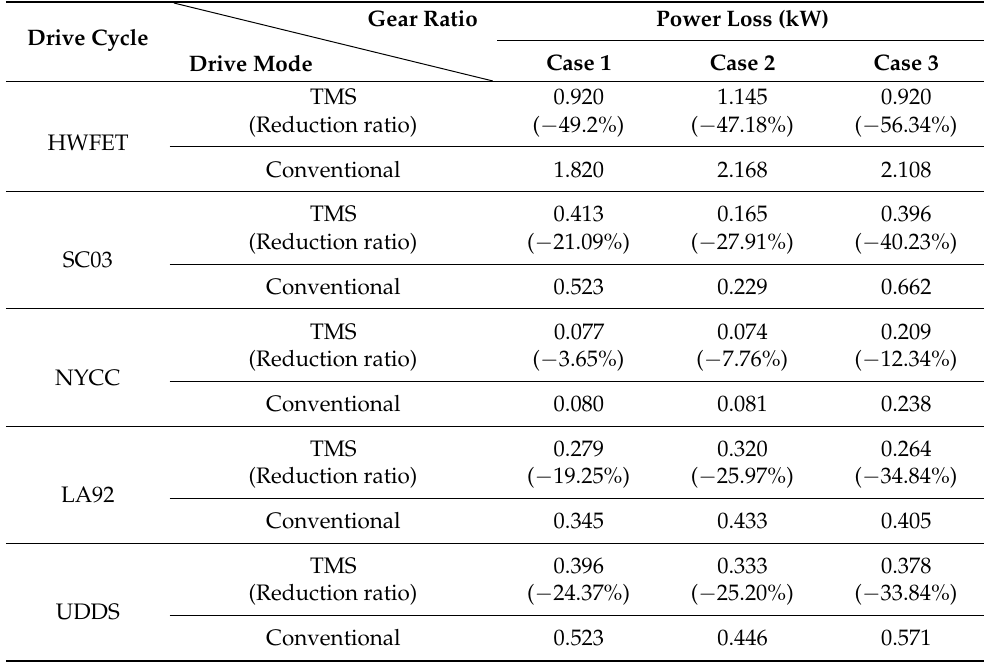
Table 3. Average power loss of the motor of the conventional system and TMS according to the gear ratio configuration in five